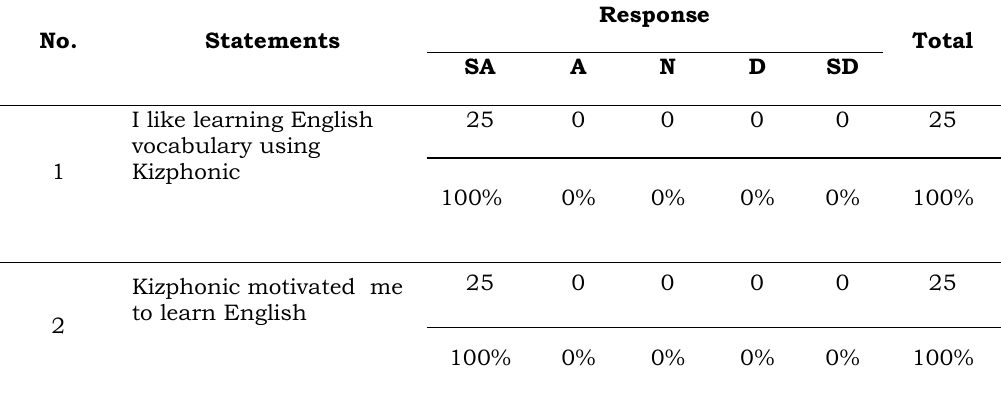
Table 4. Response to the questionnaire number